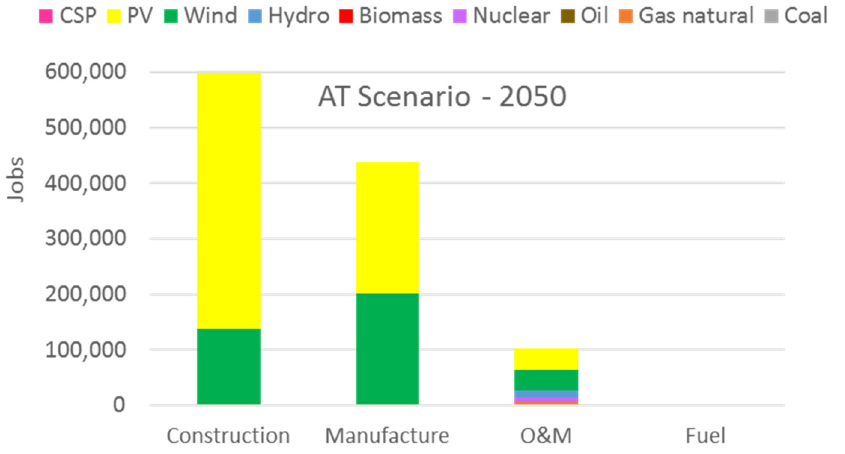
Figure 17. Breakdown of direct employment generation by life cycle phase (construction, manufacturing, Operation and Management, and fuel) in 2050 for the AT scenario.